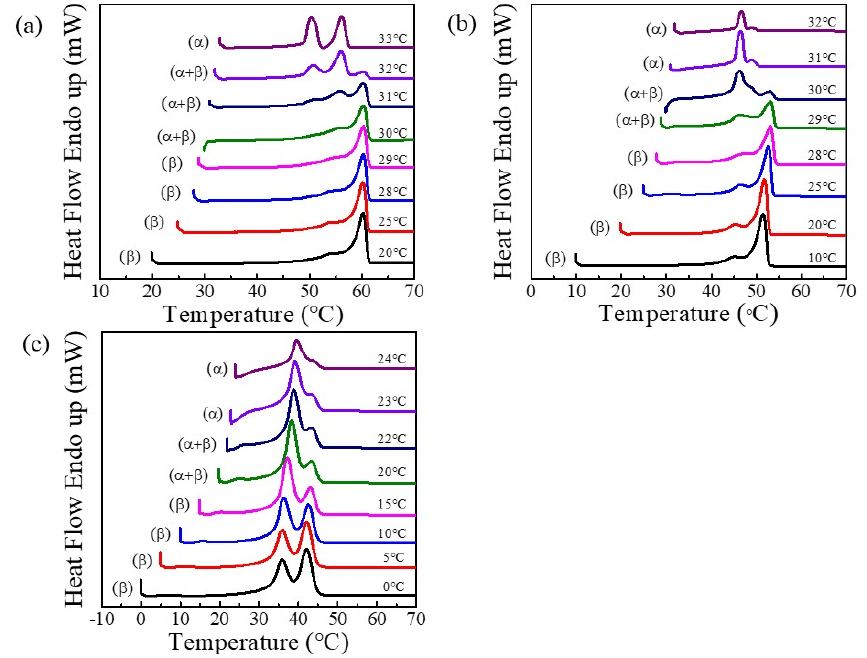
Figure 2. DSC heating curves of ( a ) g-PBA, ( b ) g-PBAT-90, and ( c ) g-PBAT-80, crystallized at different temperatures, as indicated on traces.